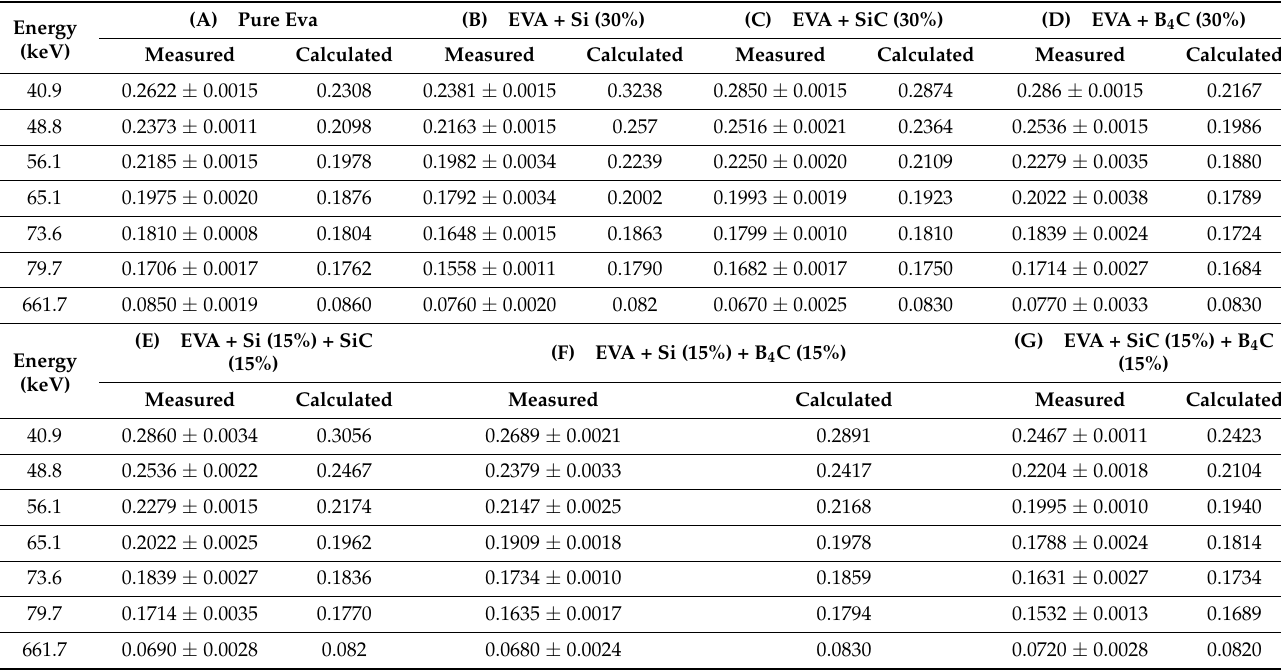
Table 2. The measured and calculated µ m expressed in cm 2 g −1 versus incident photon beam energy for the EVA based polymer composites coded A, B, C, D, E, F and G.